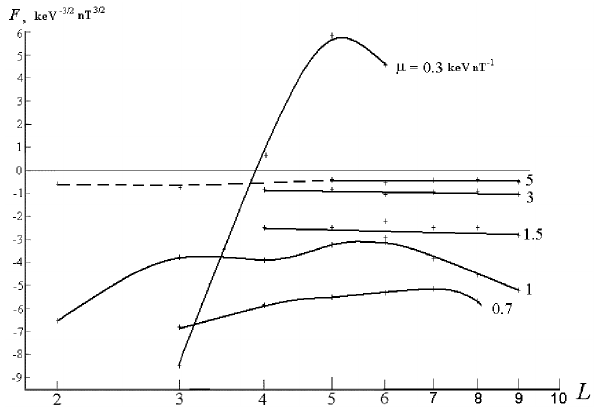
Figure 4. The functions F(L , µ) , as in Eqs. (10)–(11), for the Coulomb losses of protons with µ from 0.3 to 5keVnT − 1